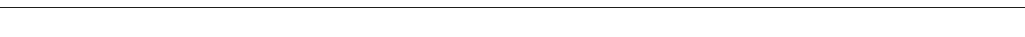
Fig. 9 TNF regulates IL-23A expression by phosphorylating N-WASP and degradation of G9a/GLP complex. a qRT-PCR analysis of IL-23A mRNA expression in con and ko primary keratinocytes treated for 4 h with TNF α ( n : 3/3, mean ± SD, two-tailed unpaired t -test). b FACS analysis of surface TNF-RI in primary keratinocytes ( n : 3/3, two-tailed unpaired t -test). c Primary keratinocytes were treated for indicated times with TNF α and then tested by immunoblot for expression of indicated proteins ( n : 4/4). d Primary keratinocytes were treated for indicated time with TNF, fractionated, and analyzed by immunoblot for indicated proteins (C: cytosolic fraction, S300: soluble nuclear fraction extracted by 300 mM NaCl, P300: pellet after 300 mM NaCl extraction, SE: short exposure, LE: long exposure; n : 3). e ChIP of primary keratinocytes for H3K9me2 with qRT-PCR for indicated regions of IL-23A promoter after treatment with TNF α for indicated times ( n : 5/5, mean ± SD, two-tailed unpaired t -test). f qRT-PCR analysis of IL-23A mRNA expression